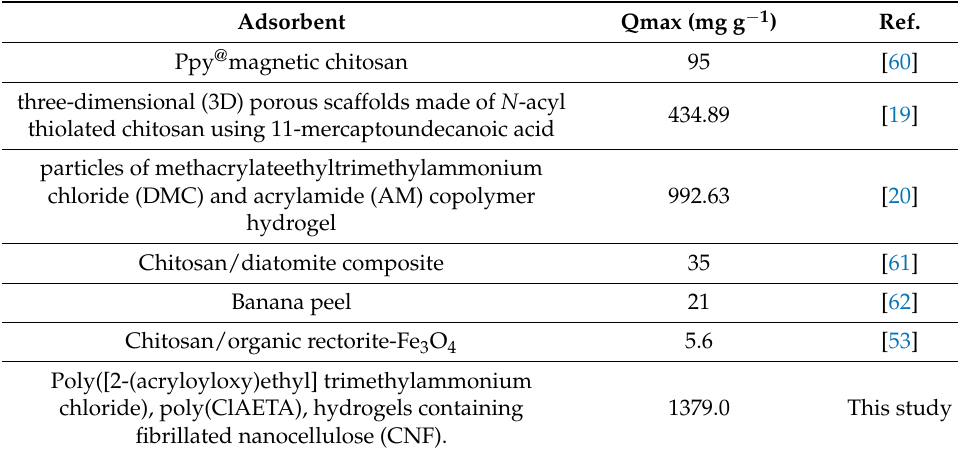
Table 5. Comparative table of maximum adsorption results. Adsorbent